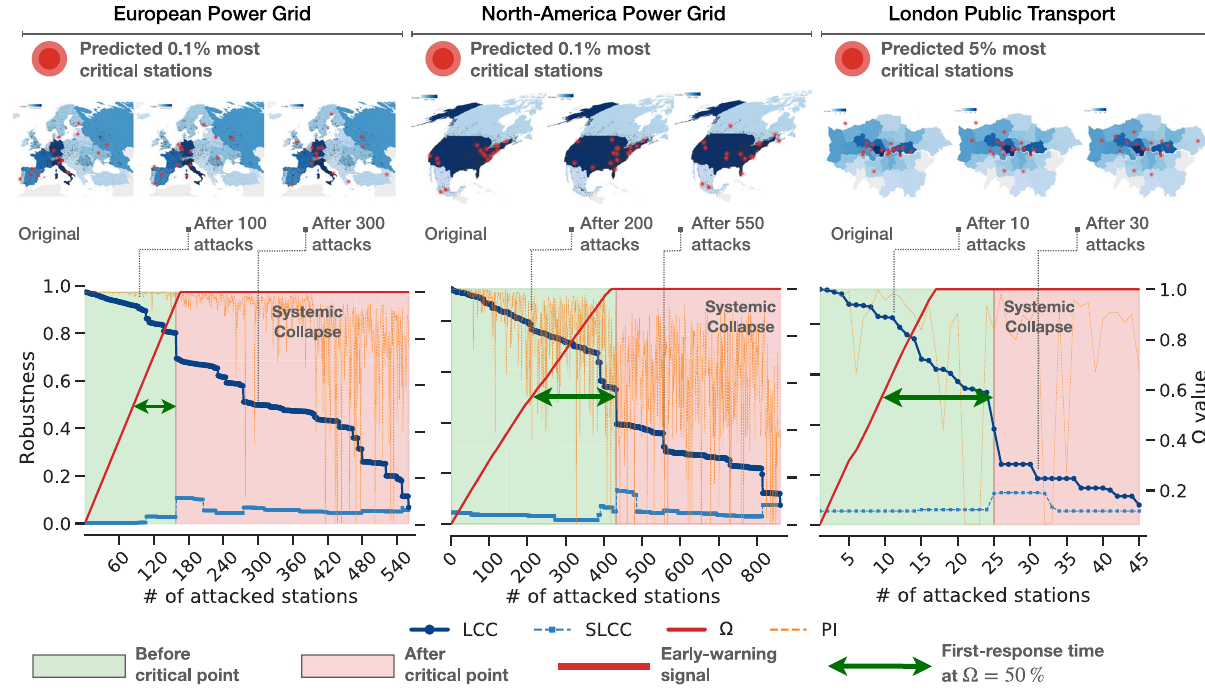
Fig. 8 Early warning due to network dismantling of real infrastructures. Three empirical systems, namely the European power grid (left), the North- American power grid (middle) and the London public transport (right), are repeatedly attacked using a degree-based heuristics, i.e., hubs are damaged fi rst. A fraction of the most vulnerable stations is shown for the original systems and some representative damaged states (i.e., before and after the critical point for system ’ s collapse), in the top of the fi gure. The plots show the behavior of the largest (LCC) and second-largest (SLCC) connected components, as well as the behavior of Ω , the early-warning descriptor introduced in this study and the p n value of each removed node (PI). Transitions between green and red areas indicate the percolation point of the corresponding systems, found through the SLCC peak. We also show the fi rst response time in arbitrary units (arb. units), to highlight how our framework allows to anticipate system ’ s collapse, allowing for timely emergency